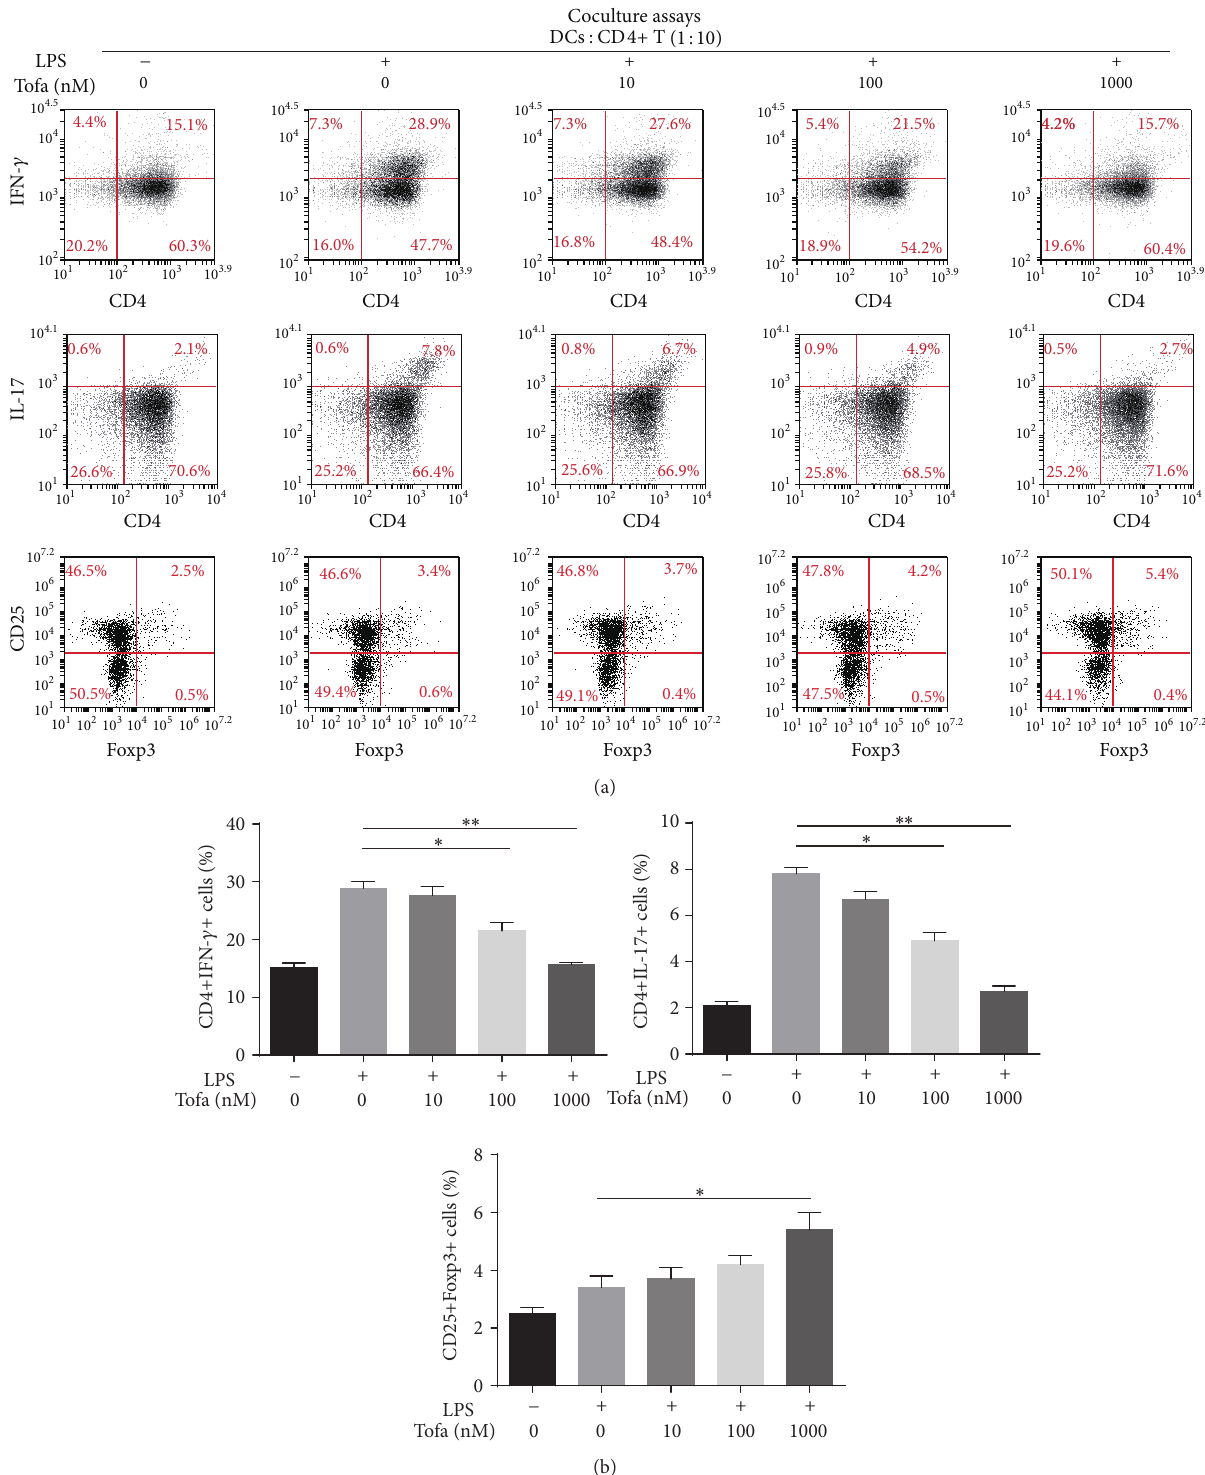
Figure 6: MOG 35 pulsed-Tofa-DC induced the hyporesponsiveness of antigen-specific T cells. (a) Activated CD4+ T cells were harvested - 55 andtheexpressionsofIL-17A,IFN- 𝛾 ,andfoxp3wereanalyzedbyintracellularstainingandflowcytometryinthegateofCD4+TcellsorCD4+ CD25+ T cells. (b) Histograms showed the percentage of IL-17A, IFN- 𝛾 producing cells, or CD25+Foxp3+ T cells in coculture experiments under different conditions. The representative results of three independent experiments with similar findings are shown. Statistical testing was performed using the Mann-Whitney test. Values represent the means ± SEM, ∗ 𝑃 < 0.05 , and ∗∗ 𝑃 < 0.01